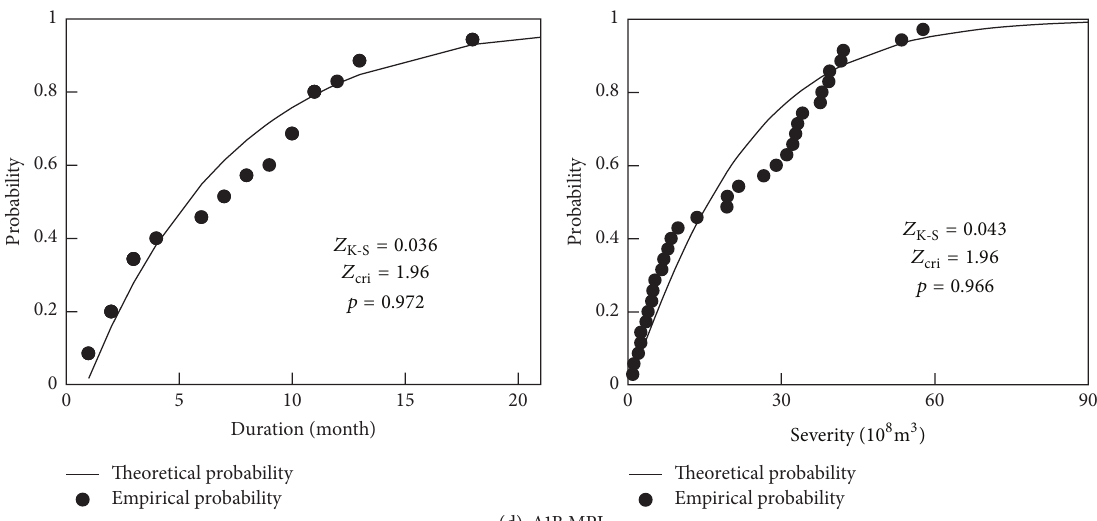
Figure4:TheoreticaldistributionfittingforseverityanddurationunderbaselineandA1BscenarioswithZ-scoreoftwo-sampleKolmogorov- is the calculated Z-score of the K-S test statistics and 𝑍 cri is the critical Z-score at a 5% significance level). Smirnov test statistics ( Z K-S